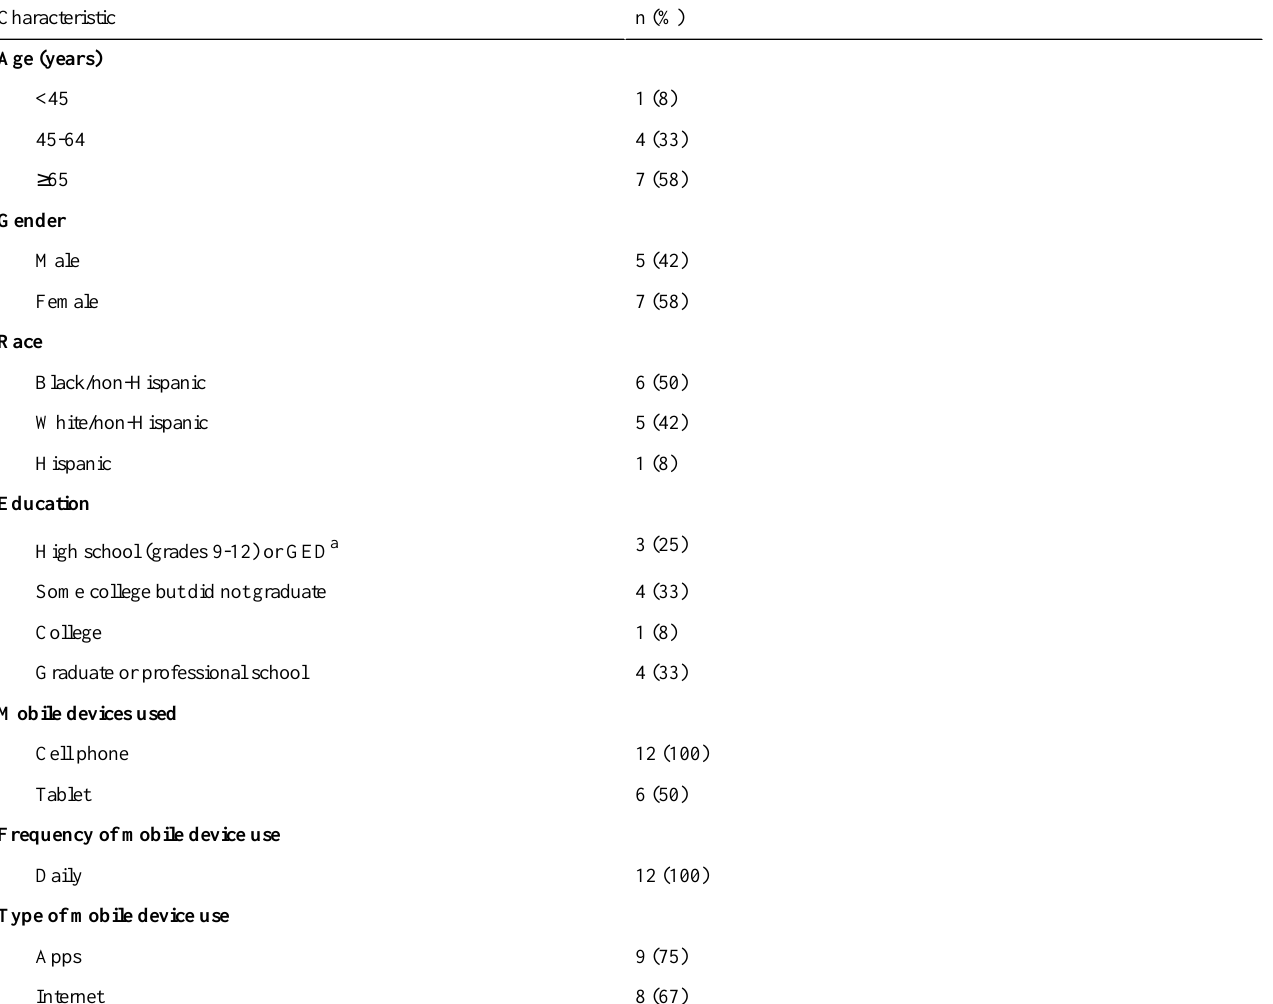
Table 2. Usability study participant demographics